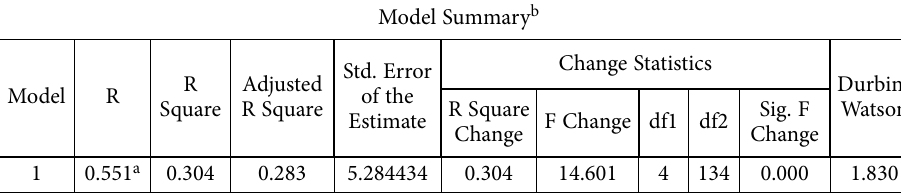
Table 8. Model summary and ANOVA (United States) (source: own construction by using